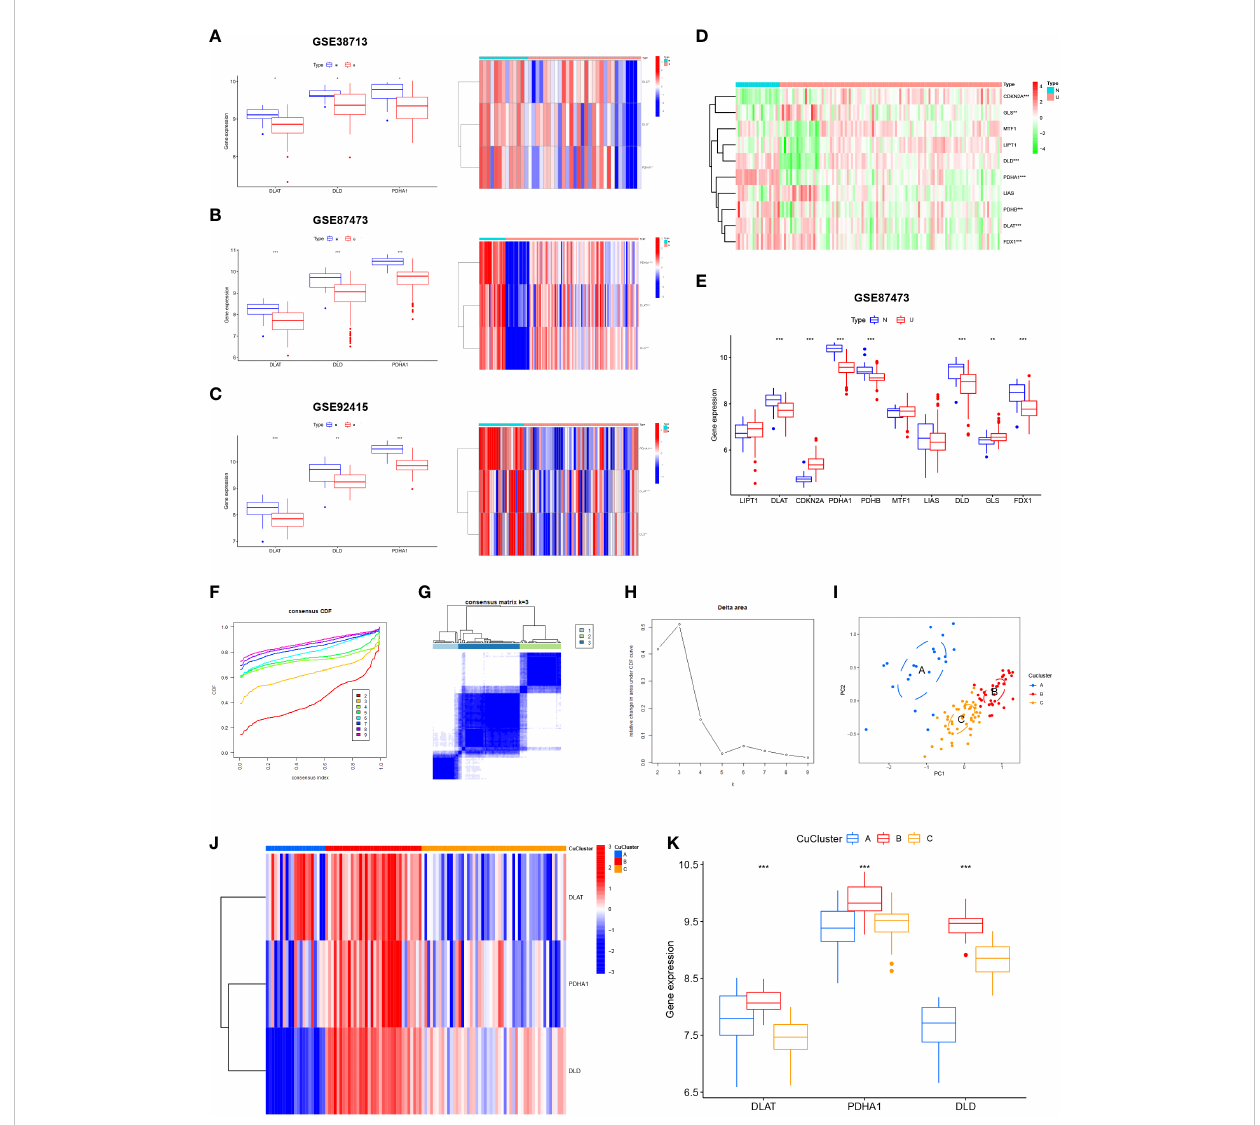
FIGURE 2 Expression of cuproptosis-related genes in ulcerative colitis (UC) patients. (A) Expression of three cuproptosis-related genes in GSE38713. (B) Expression of three cuproptosis-related genes in GSE92415. (C) Expression of three cuproptosis-related genes in GSE87473. (D) Heat map indicated the expression of 10 cuproptosis-related genes in normal tissues and UC patients. (E) Box line plot depicted the expression of 10 cuproptosis-related genes in normal tissues and UC patients. ( F – H ) Three subgroups were identi fi ed based on the expression of three cuproptosis-related genes using unsupervised consistent clustering. (I) Visualization of clustering results using the PCA method. (J, K) Evaluation of the expression of three cuproptosis-related genes in different cuproptosis subtypes. N, normal, normal tissues; U: UC, UC patients; CuClusterA, cuproptosis-ClusterA; CuClusterB, cuproptosis-ClusterB; CuClusterC, cuproptosis-ClusterC. The asterisk represents the statistical p -value (* p < 0.05; ** p < 0.01; *** p <